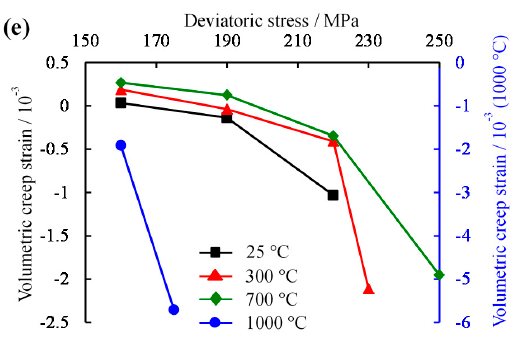
Figure 7. Volumetric creep strain ‐ time curves under step ‐ loading at different temperatures ( σ 3 = 25 MPa): ( a ) 25 °C; ( b ) 300 °C; ( c ) 700 °C; ( d ) 1000 °C; ( e ) Relationship between volumetric creep strain and deviatoric stress.